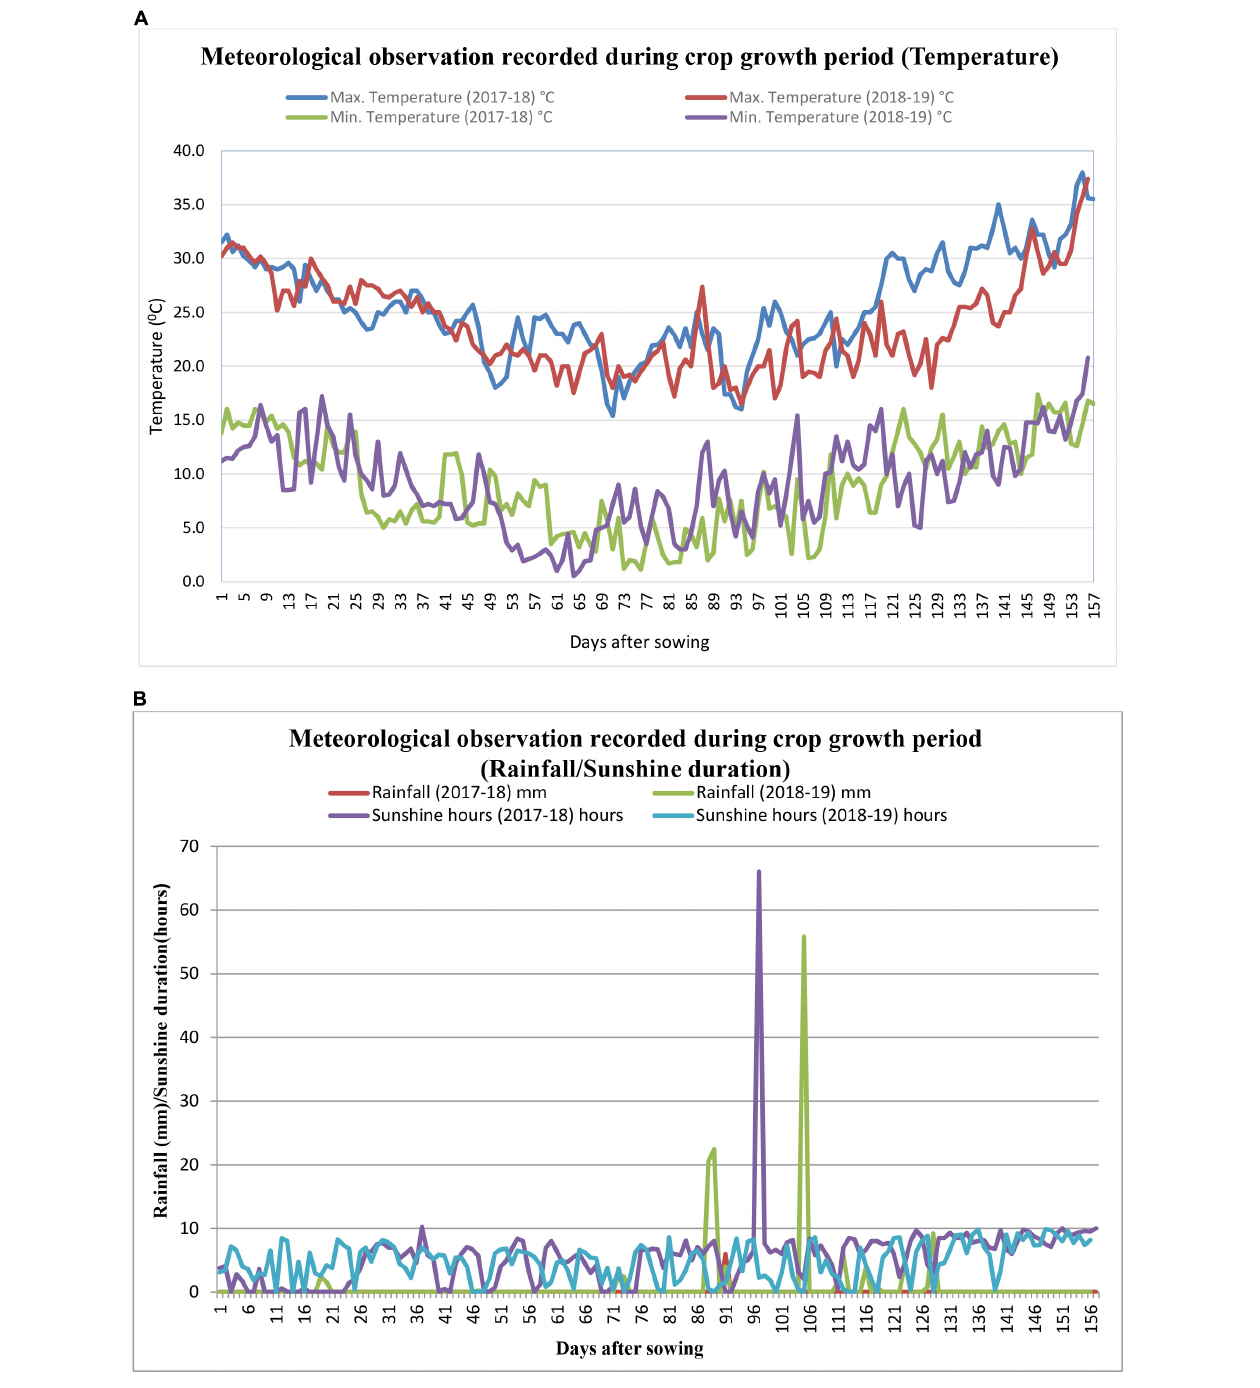
FIGURE 1 | (A) Daily maximum and minimum temperatures ( ◦ C) recorded during the crop grown period (2017–2018 and 2018–2019). (B) Rainfall (mm) and sunshine hours recorded during the crop grown period (2017–2018 and 2018–2019).